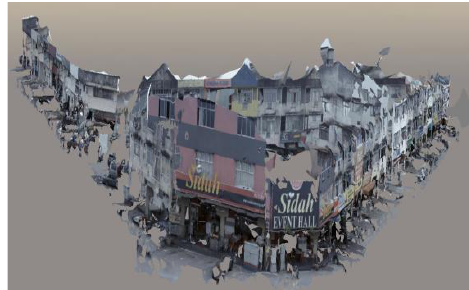
Figure 6: 3D Mesh Model for Taman Perindustrian Saujana Indah.